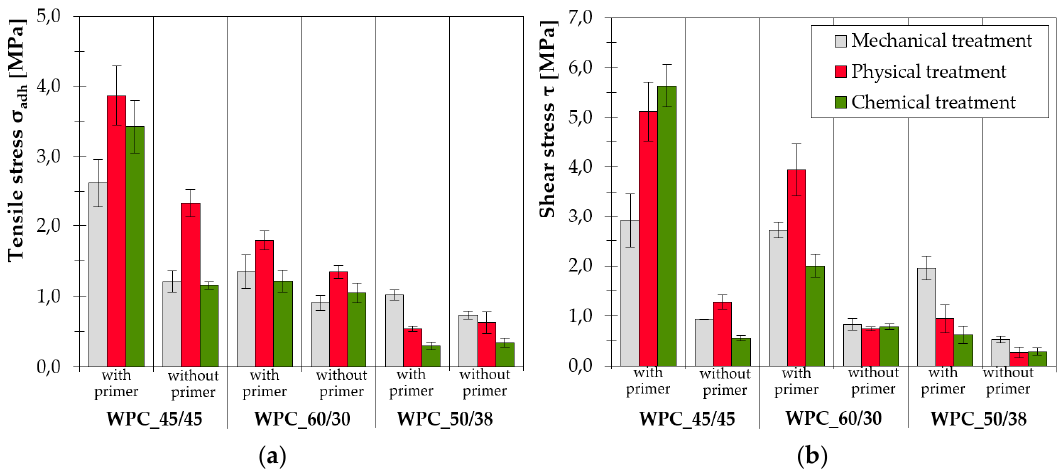
Figure 7. Comparison of average stress values: ( a ) in tension and ( b ) in shear after surface treatment. The results of samples with and without primer are compared. The standard error in the mean is presented in the error bar.